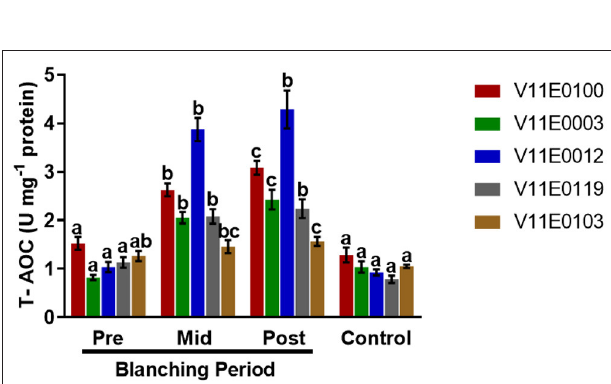
FIGURE 5 | Effect of blanching on the total polyphenols and flavonoids content in the stem of five water dropwort cultivars. (A) Total polyphenols content, and (B) total flavonoids content. Four types of samples were analyzed; Pre-blanching, Mid-blanching (20 days), Post-blanching (40 days), and Control (grown under normal conditions). Different letters indicate a significant difference ( P < 0.05) among the treatments according to the Tukey test. Values are means ± SE.